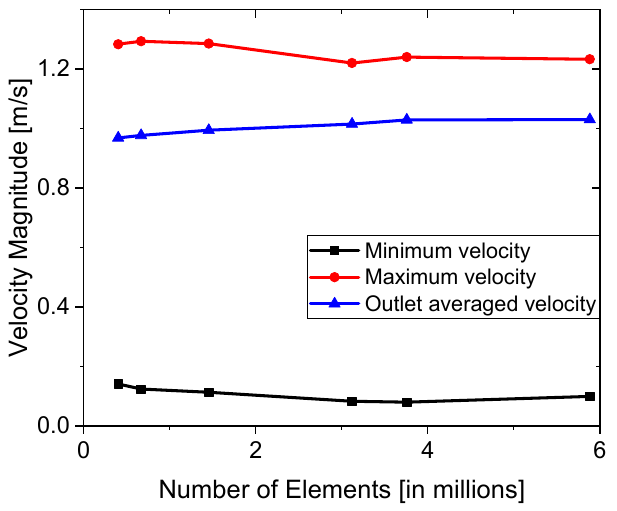
Figure 2. Grid independence test. Volume flow rate: 250 LPM, gas: air.